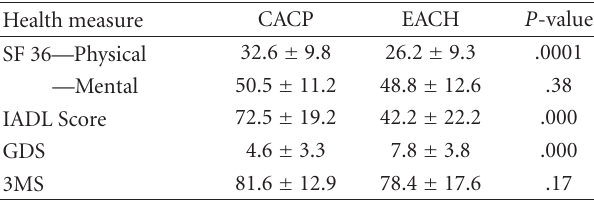
Figure 1: Prevalence of comorbid conditions in the PITCH population. Table 1: Baseline health characteristics of the PITCH